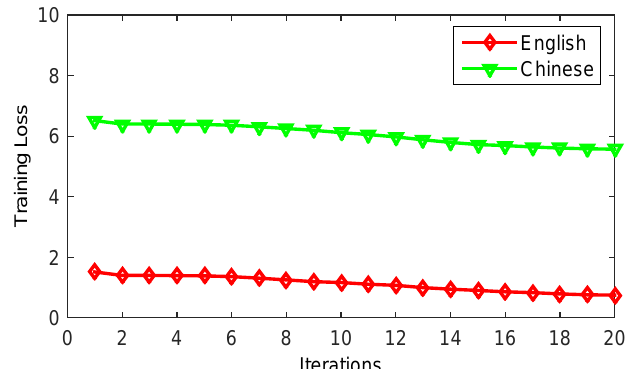
Figure 10. Comparison of different datasets with deep neural networks (hidden layer = 1, region size = 3, neurons = 500).